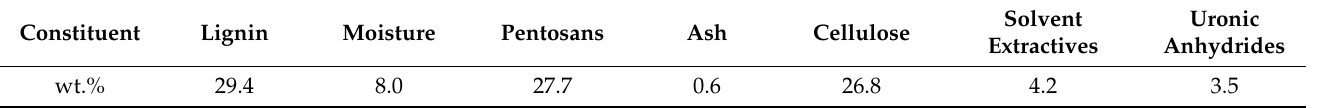
Table 1. Chemical composition of the coconut husk